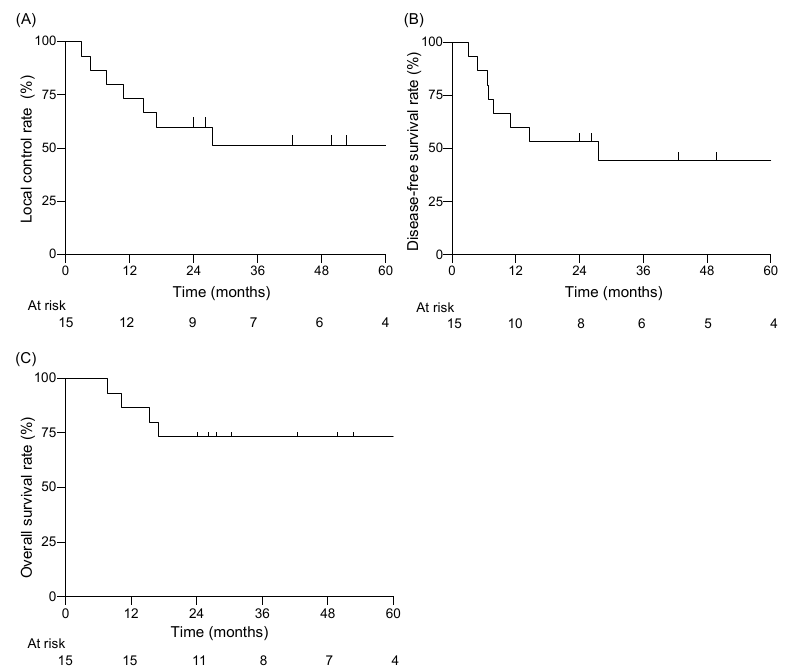
Figure 1. Kaplan–Meier curves for ( A ) local control rate, ( B ) disease-free survival rate, ( C ) overall survival rate.